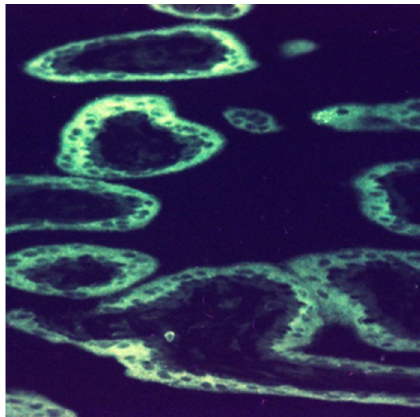
Figure 5. Human placental lactogen secretion from the syncytiotrophoblast at 12 w 2 d (x320). The fluorescent reaction with fluorescein-isothiocyanate (FITC)-labeled anti-hPL (rabbit) is confined to the syncytiotrophoblast layer of chorionic villi, thus creating the image of a “white ring”.